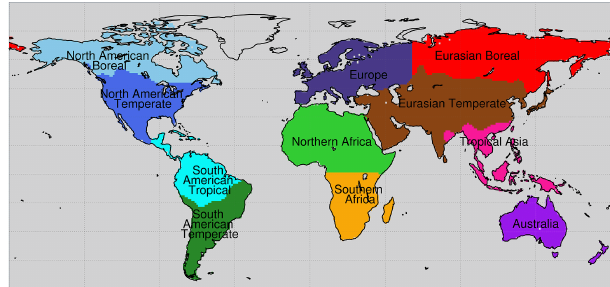
Figure 6. The Transcom regions over which the 4 ◦ × 5 ◦ gridded data are then averaged in Fig.